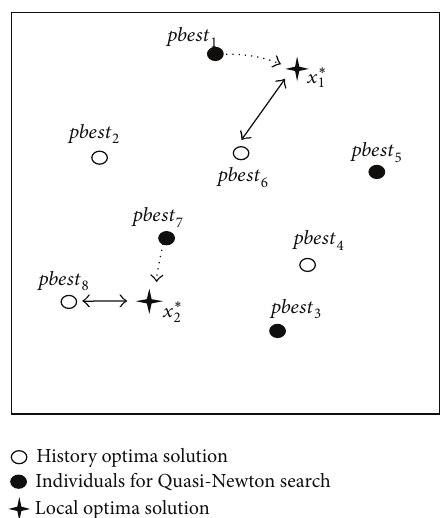
Figure 3: Local search process of Quasi-Newton algorithm.